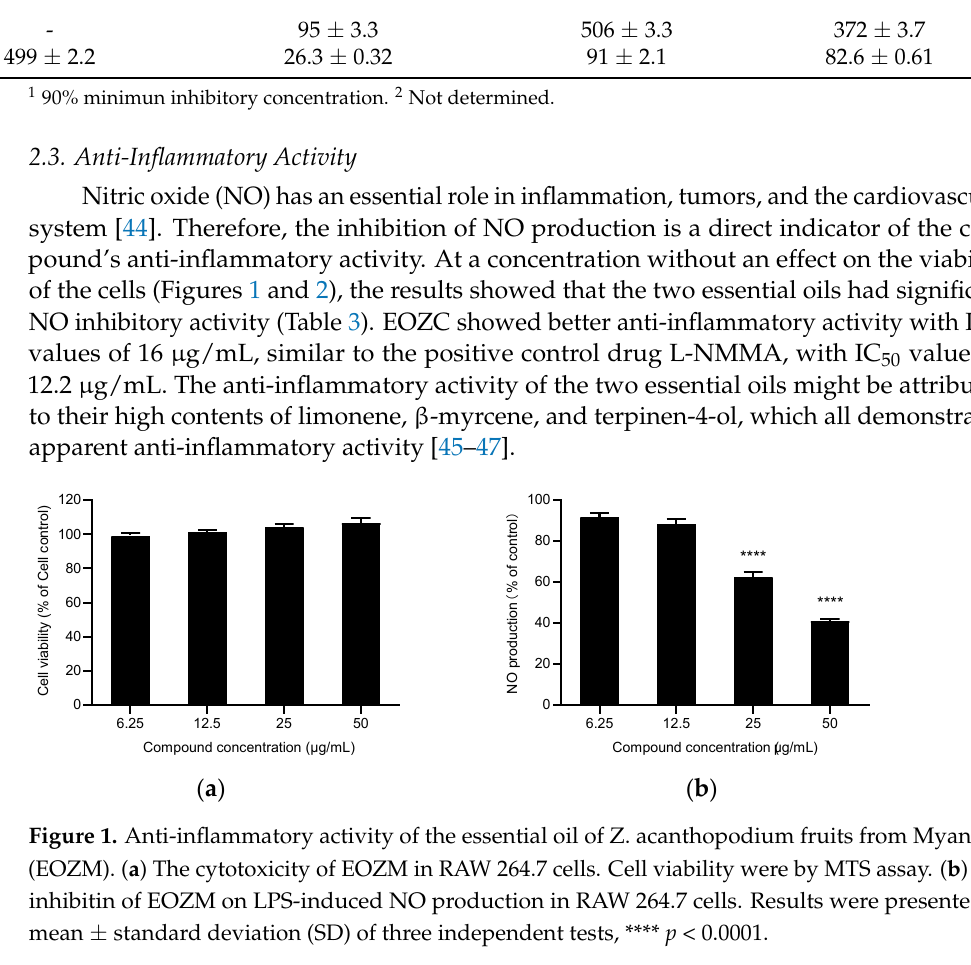
Figure 2. Anti-inflammatory activity of the essential oil of Z. acanthopodium fruits from Myanmar (EOZC). ( a ) The cytotoxicity of EOZC in RAW 264.7 cells. Cell viability were by MTS assay. ( b ) The inhibitin of EOZC on LPS-induced NO produc-tion in RAW 264.7 cells. Results were presented as mean ± standard deviation (SD) of three independent tests, *** p = 0.002, **** p < 0.0001. Table 3. Anti-inflammatory activity of essential oils from Z. acanthopodium fruits . Compound